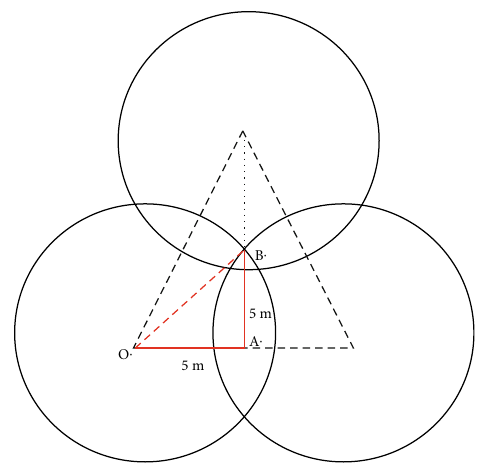
Figure 13: Layout of grouting